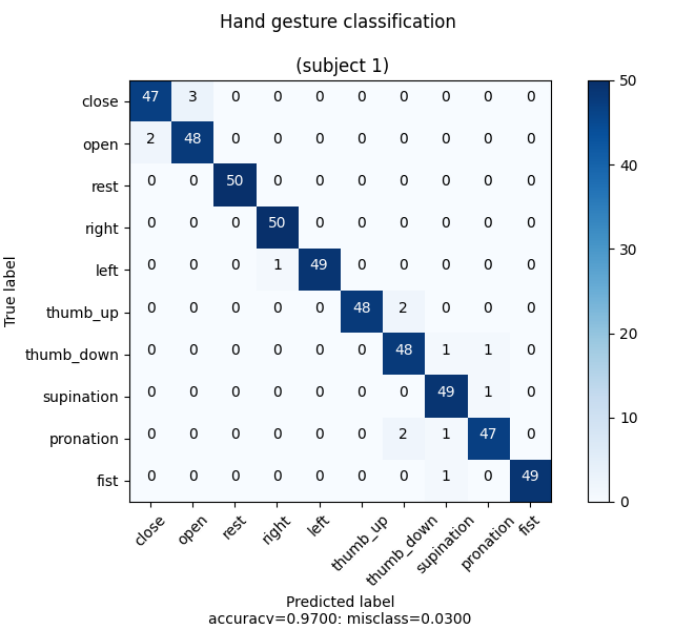
Figure A1. Confusion matrix of a subject who participated in data collection (subject 1).